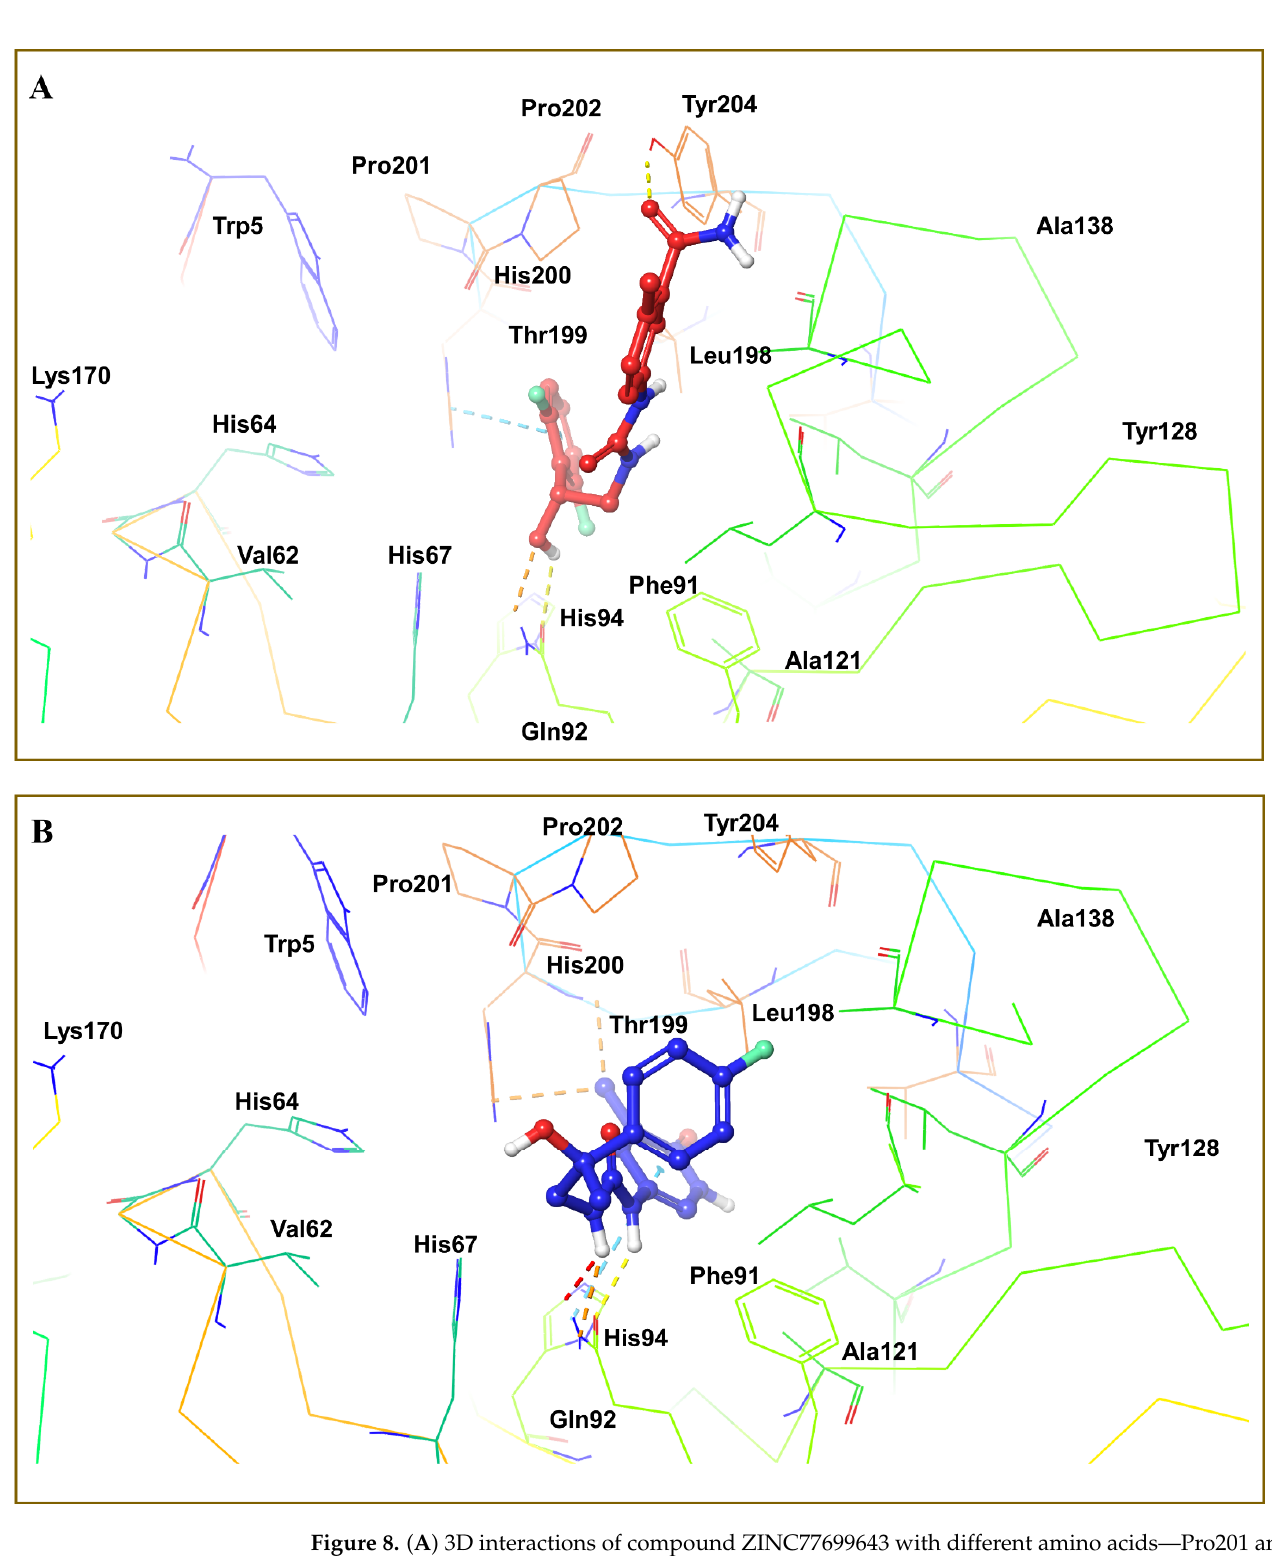
Figure 8. ( A ) 3D interactions of compound ZINC77699643 with different amino acids—Pro201 and Thr199—at the binding site of receptor 6g3v. ( B ) 3D interactions of compound ZINC89275054 with different amino acids—His94, Gln92, and Thr199—at the binding site of receptor 6g3v.